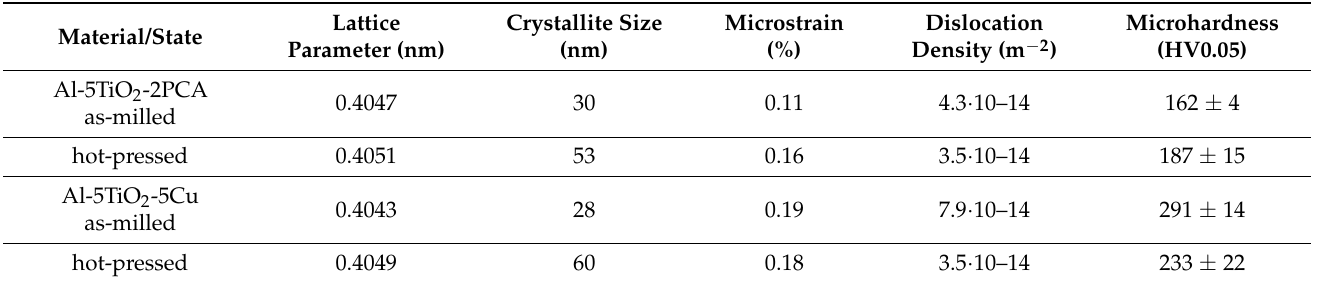
Table 2. Microstructural parameters of the aluminum matrix obtained by XRD analysis and micro- hardness for different